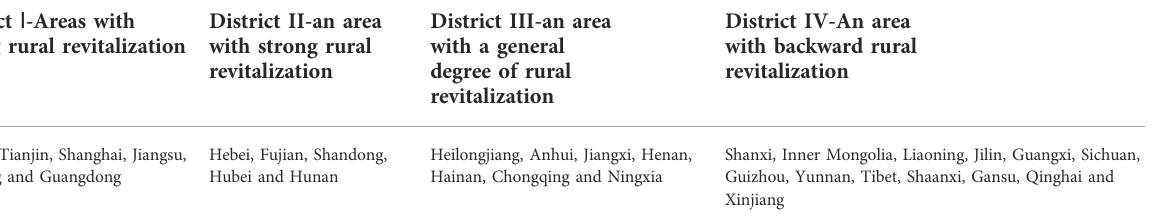
TABLE 2 Classi fi cation table of four regions of 31PLAD. District Ⅰ -Areas